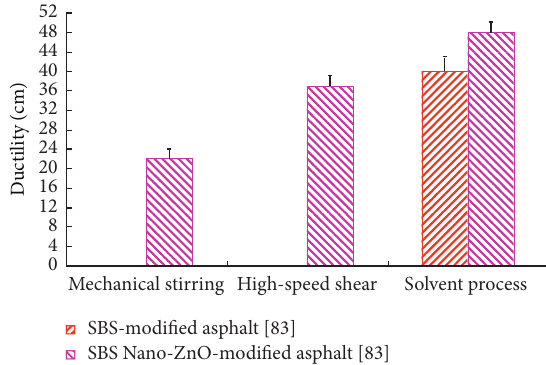
Figure 26: Ductility of different preparation